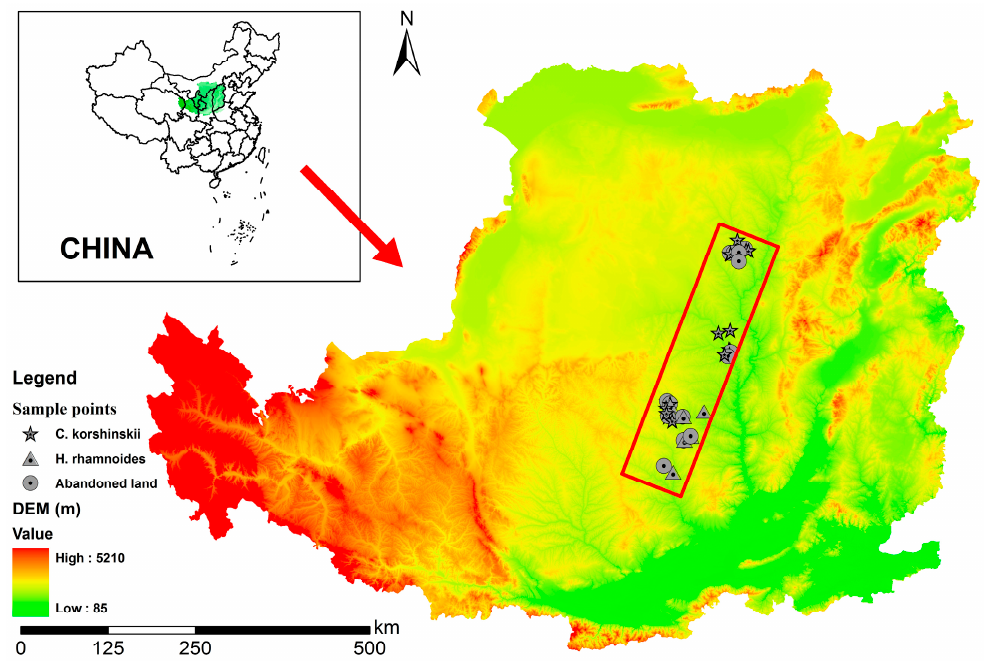
Figure 1. Location of the Loess Plateau and the sample points of the study area.